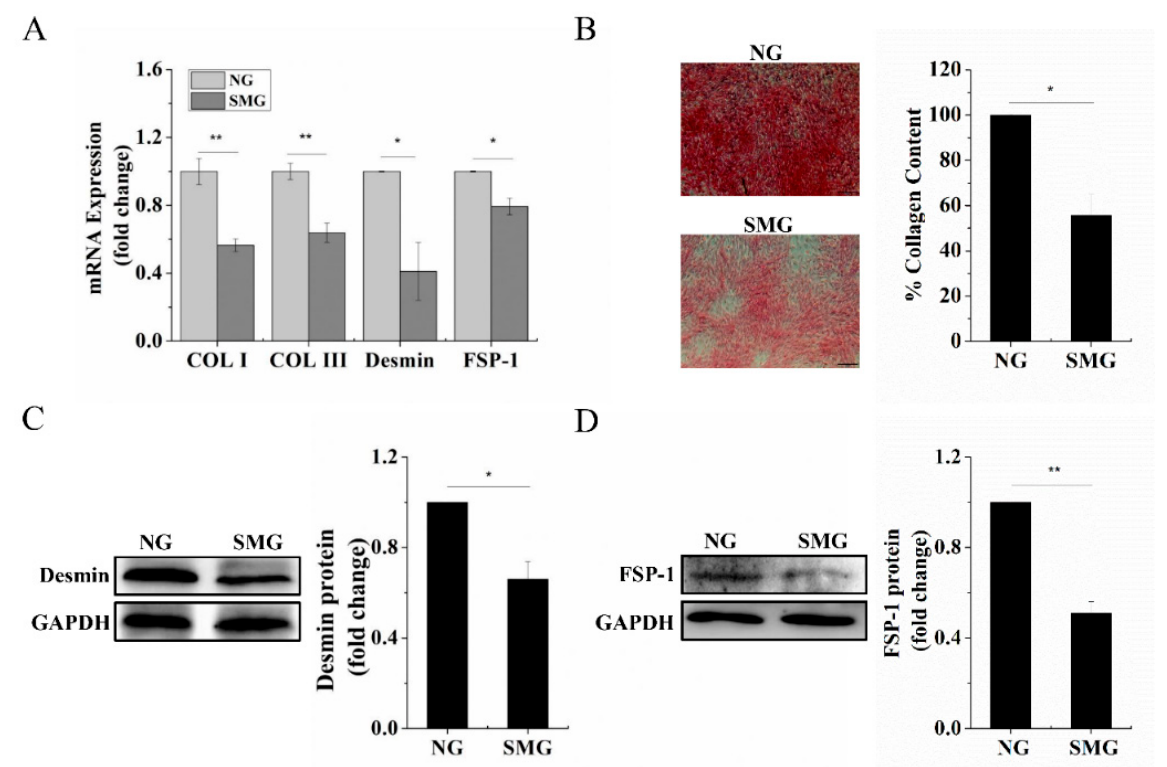
Figure 3. SMG inhibited dermal fibroblastic differentiation of BMSCs after exposure to SMG for 7 days. ( A ) mRNA expression of Col I, Col III, Desmin, and FSP-1 after 7 days of induction under SMG conditions and NG by RT-qPCR detection. ( B ) Sirius red staining for Col I and Col III deposition evaluation in BMSCs and quantification data of Sirius red staining after 7 days of induction under SMG conditions and NG (scale bar, 100 µ m). ( C ) Western blot detection of the Desmin protein level after 7 days of induction under SMG conditions and NG. ( D ) Western blot detection of the FSP-1 protein level after 7 days of induction under SMG conditions and NG. BMSCs: bone marrow-derived mesenchymal stem cells; NG: normal gravity; SMG: simulated microgravity; Col I: collagen I; Col III: collagen III; FSP-1: fibroblast-specific protein-1; GAPDH: glyceraldehyde-3-phosphate dehydrogenase. Data are presented as mean with SD; n = 3, * p < 0.05; ** p <